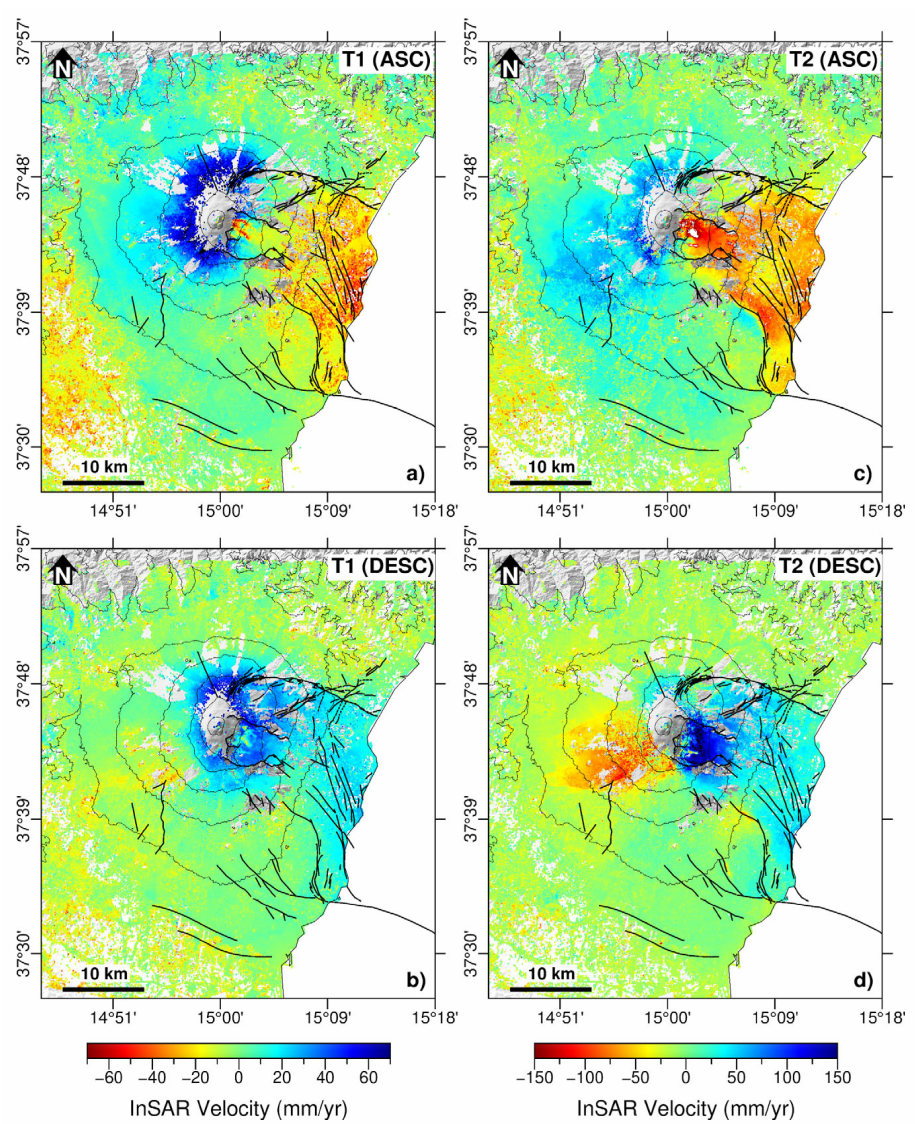
Figure 3. Ascending (panels a , c ) and descending (panels b , d ) LoS velocity maps relative to T1 (18 January 2015–22 December 2018) and T2 (28 December 2018–2 June 2019) time intervals. Positive values (blue colors) represent scatterers approaching the satellite, negative values (red colors) are moving away. Main faults are also reported as black